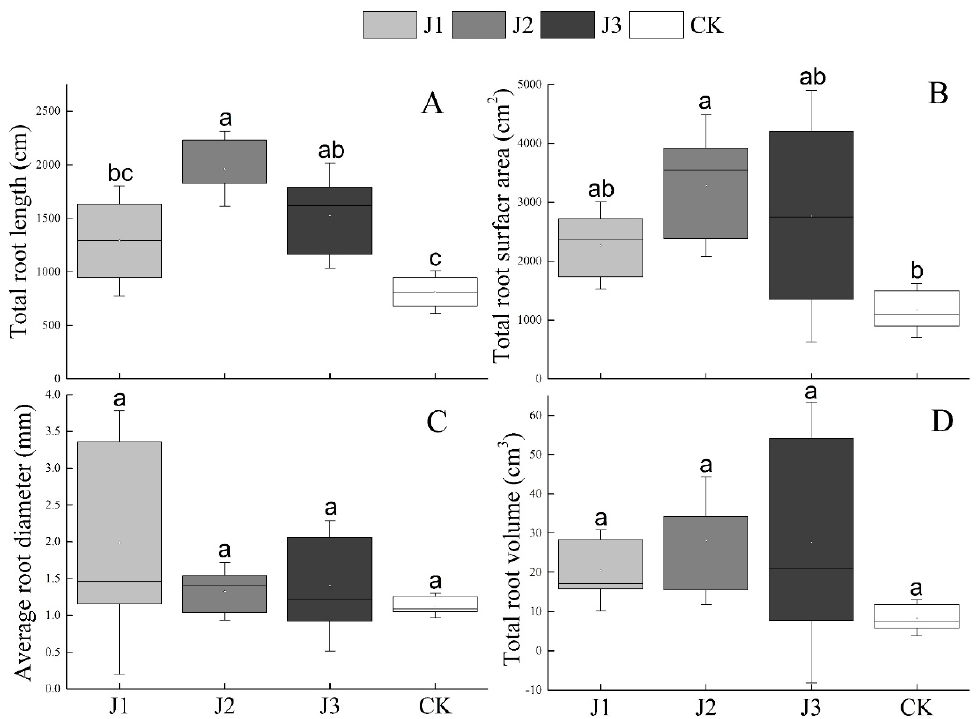
Figure 2. The root growth parameters of R. pseudoacacia measured with WinRHIZO. Empty circles within each box represent the average pH value, horizontal lines within each box represent the median pH value, and vertical lines represent the interquartile ranges. ( A – D ) Different letters show treatments that are significantly different ( p < 0.05) following a Duncan’s test. Experimental treatments: J1, NL-11; J2, NL-11 + NL-15; J3, NL-1 + NL-11 + NL-15.